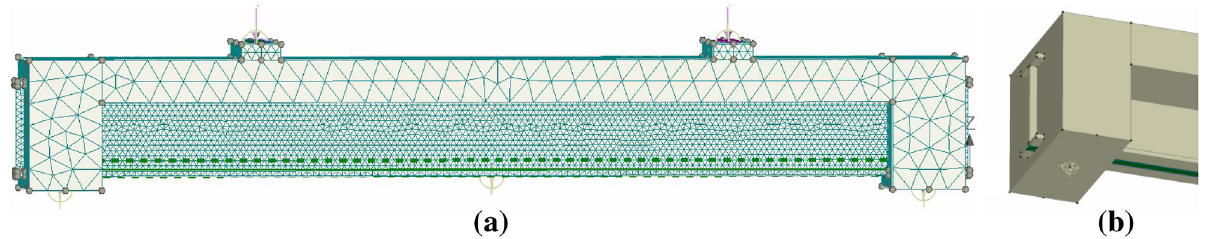
Figure 2. The finite element model of the hybrid beam: ( a ) FE discretization; ( b ) support